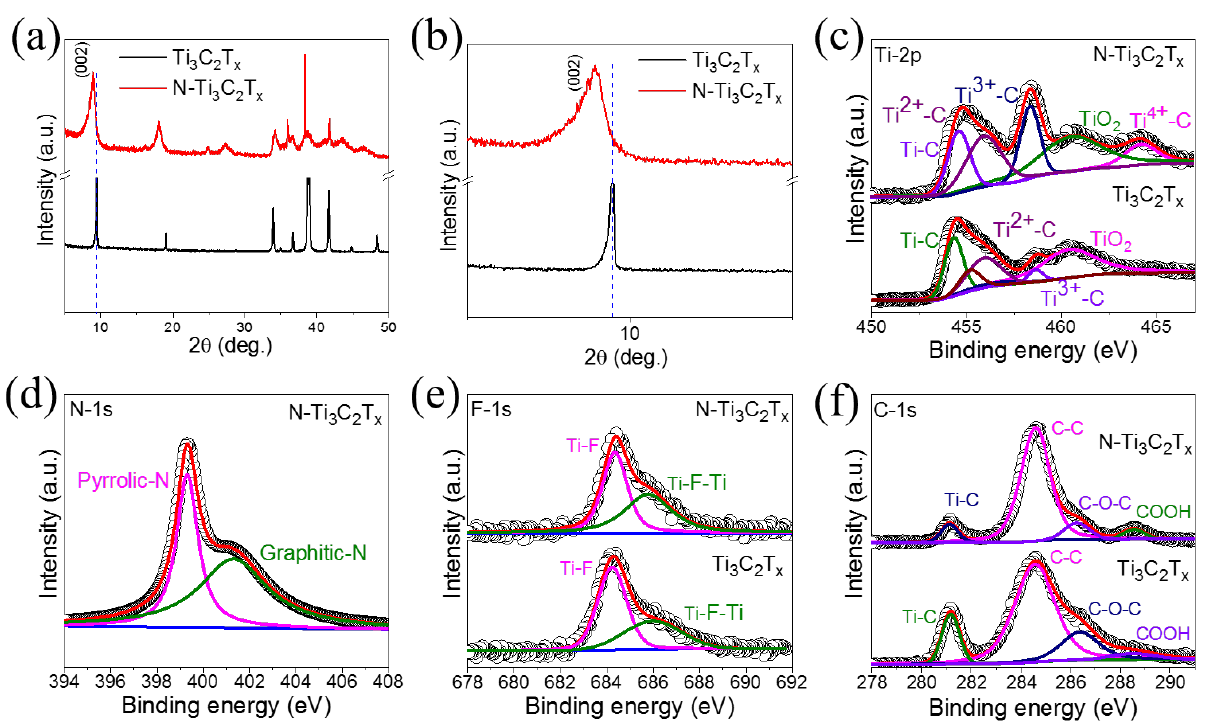
Figure 3. ( a , b ) XRD images of Ti 3 C 2 T x -MXene and N -Ti 3 C 2 T x ; deconvoluted XPS spectra of ( c ) Ti-2p; ( d ) N -1s; ( e ) F-1s; and ( f ) C-1s.